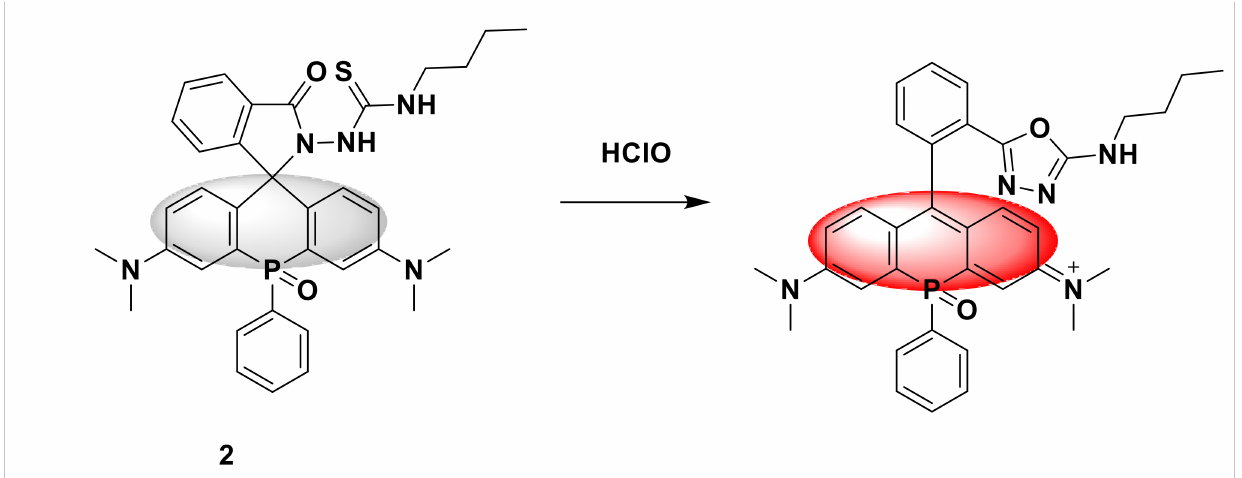
Figure 2. The reaction of probe 2 and